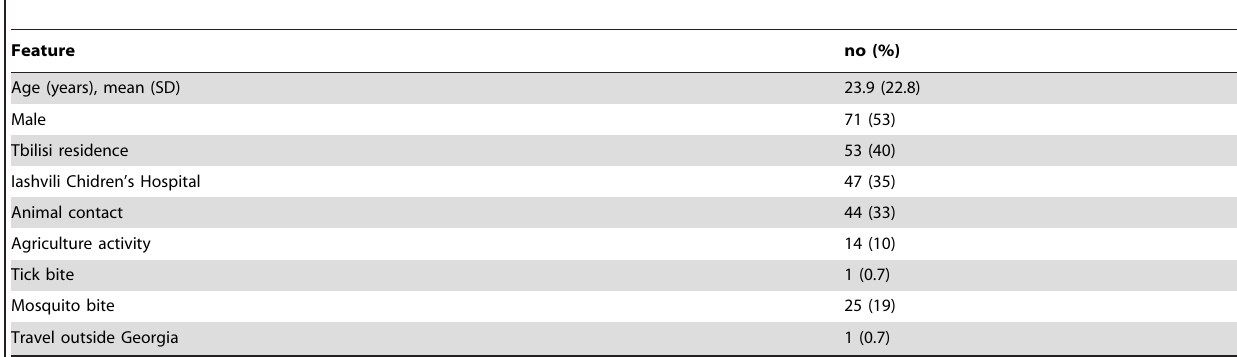
Table 1. Baseline characteristics of 140 patients presenting with febrile acute central neurologic system infections, country of